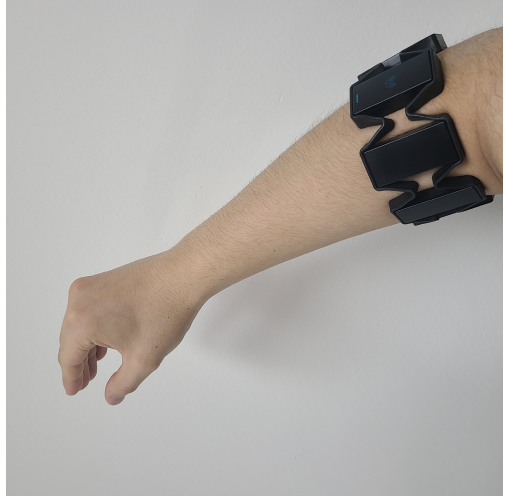
Figure 6. Band-shaped sensor worn on the user’s right forearm. Channel 4 should be aligned horizontally with the back of the user’s